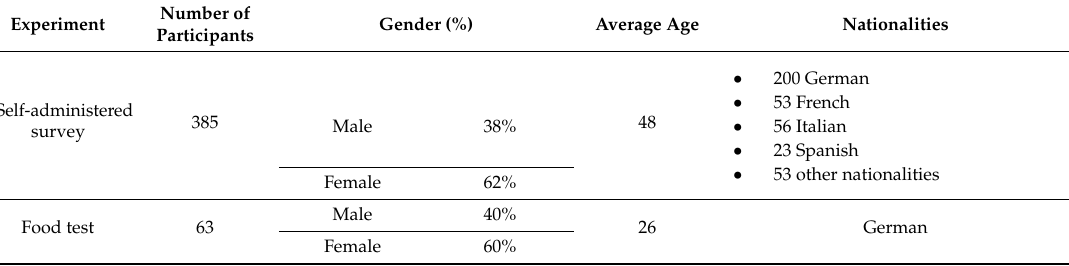
Table 1. Number, average age and gender percentage of the study sample.